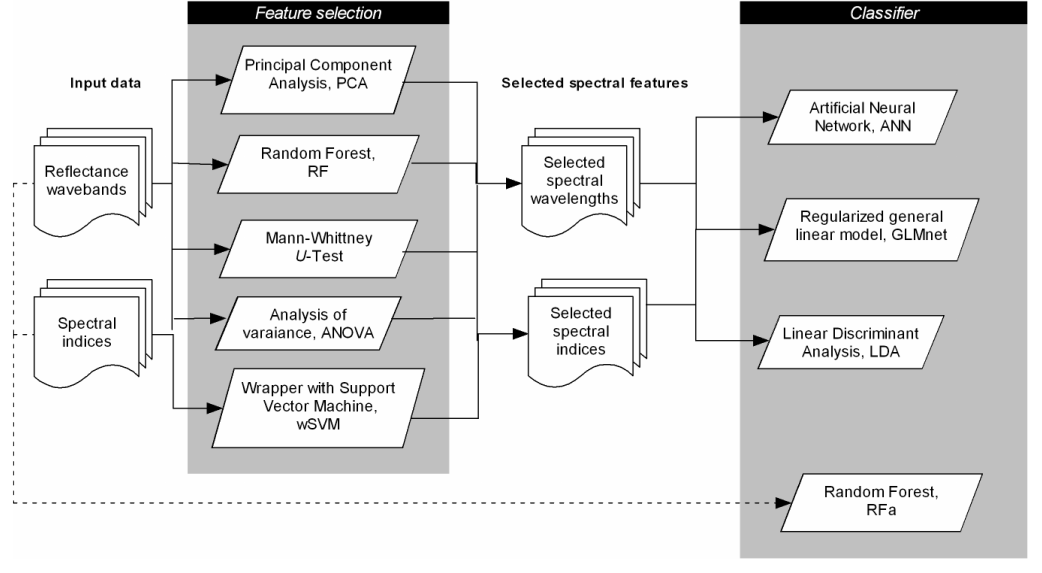
Figure 2. Flowchart showing a summary of the process followed in this